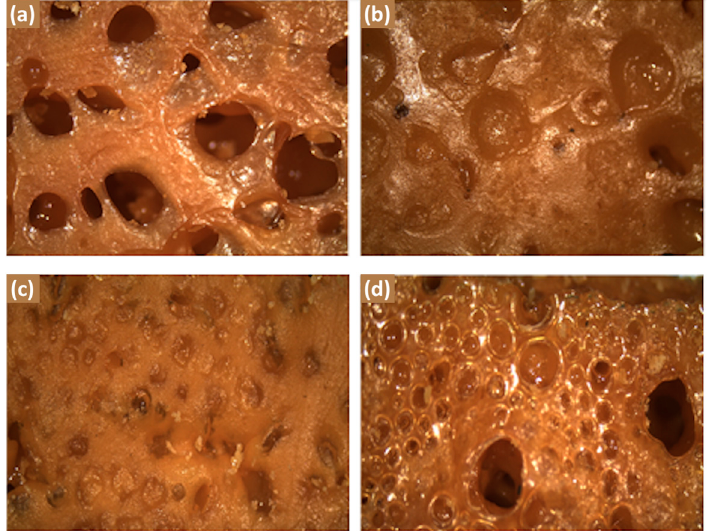
7 of 16 Figure 5. SEM micrographs of PUs before soil degradation: ( a ) PULOA, ( b ) PULOB, ( c ) PUPFOA,